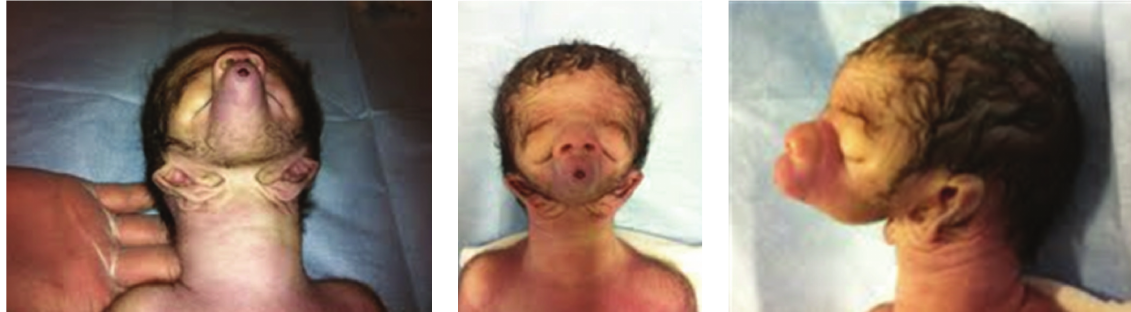
Figure 3: Postmortem image shows microstomia (characteristic of agnathia-otocephaly) and a proboscis with two nostrils.